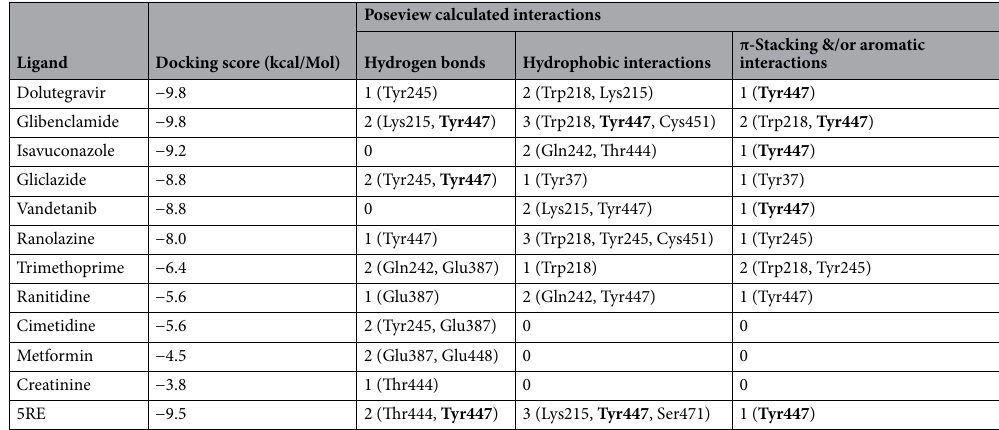
Ligand Docking score (kcal/Mol)